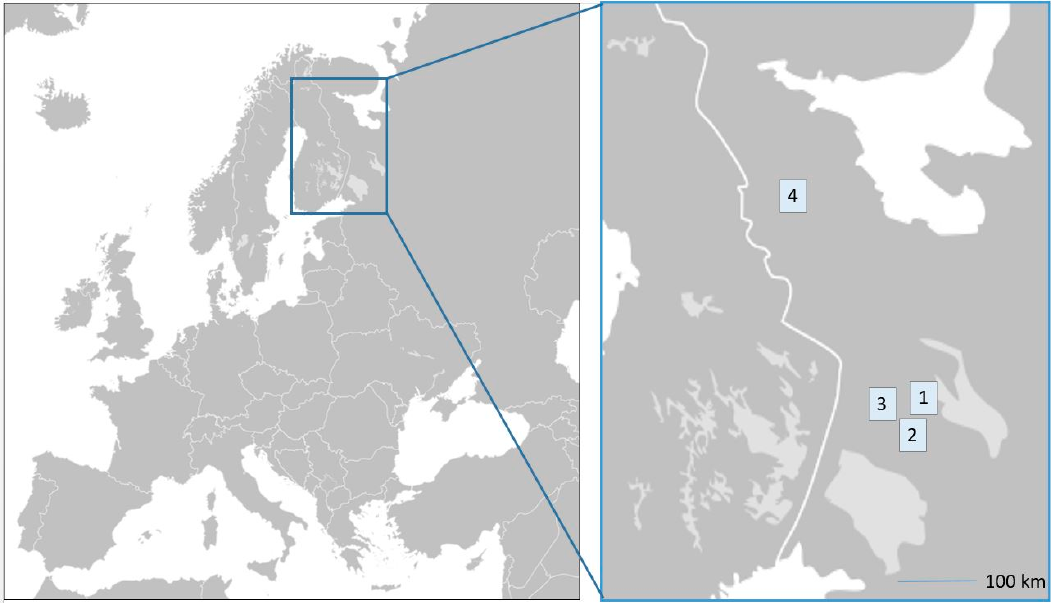
Figure 1. List of fieldwork sites: (1) Petrozavodsk, Zaozer’e, Lekhnavolok, Novaya Vilga; (2) Priazha; (3) Essoila, Korza, Rubchoila, Siamozero; (4) Kalevala. Map base: http://upload.wikimedia.org/wikipedia/commons/5/5a/BlankMap-Europe-v4.png.